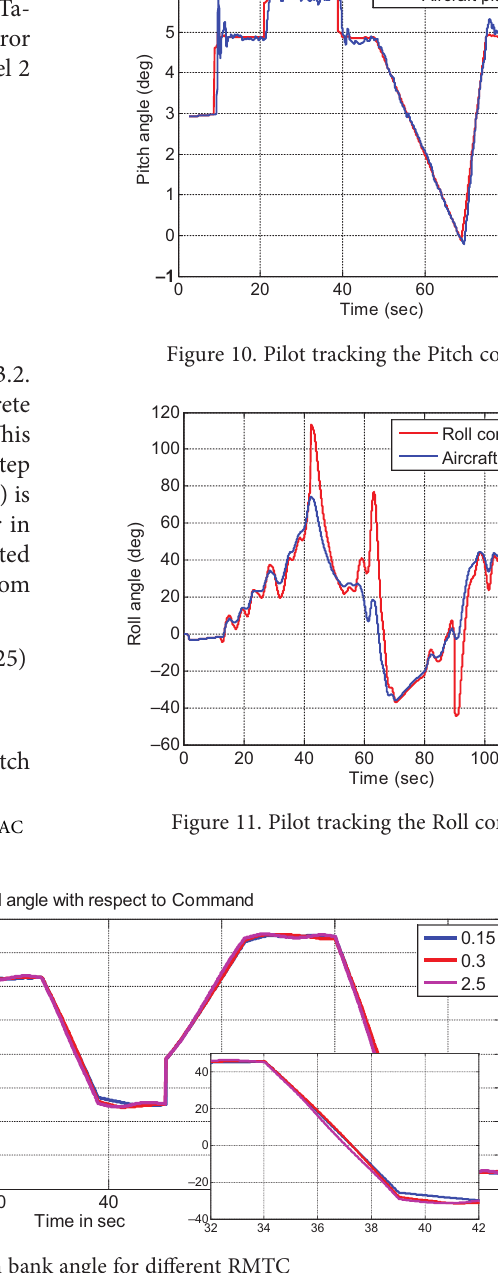
Figure 12. Error in bank angle for different RMTC